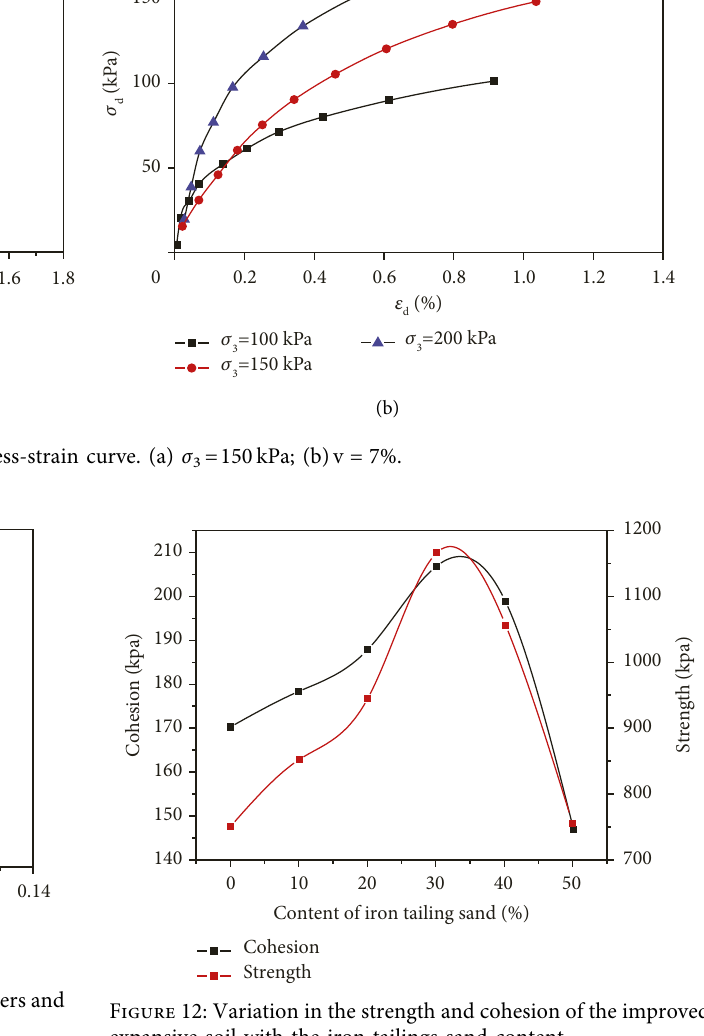
Figure 12: Variation in the strength and cohesion of the improved expansive soil with the iron tailings sand